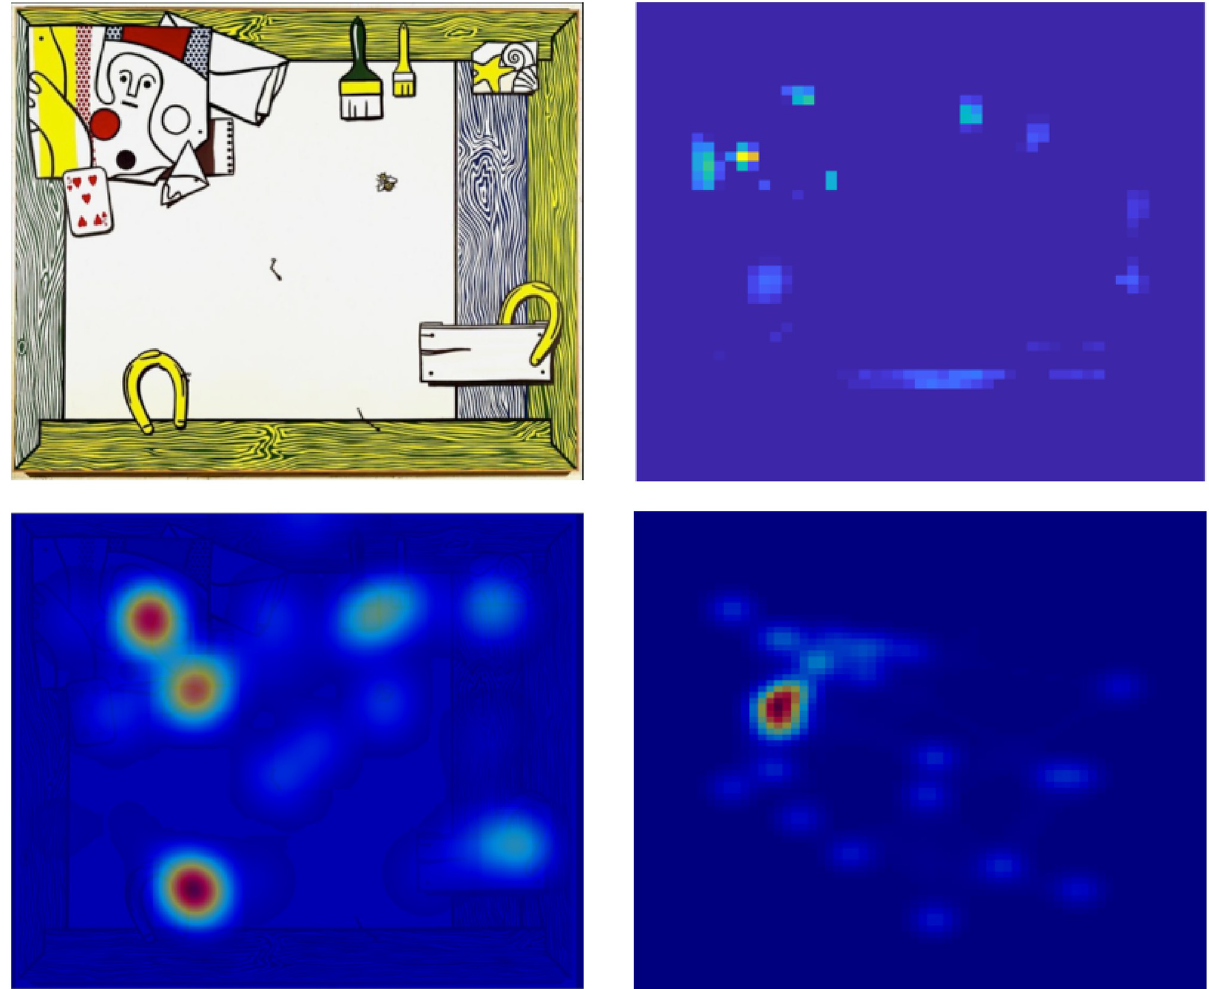
Fig 14. Salience map representation of model during free-viewing. Top left) “Things on the Wall” by Roy Lichtenstein. Top right) a salience map generated by three boundary detection iterations at different spatial scales, integrated across the dimensions of: color, orientation, and intensity. Bottom left) Fixation heat map from a typical human subject. Bottom right) Fixation heatmap from one trial of LAG-1.